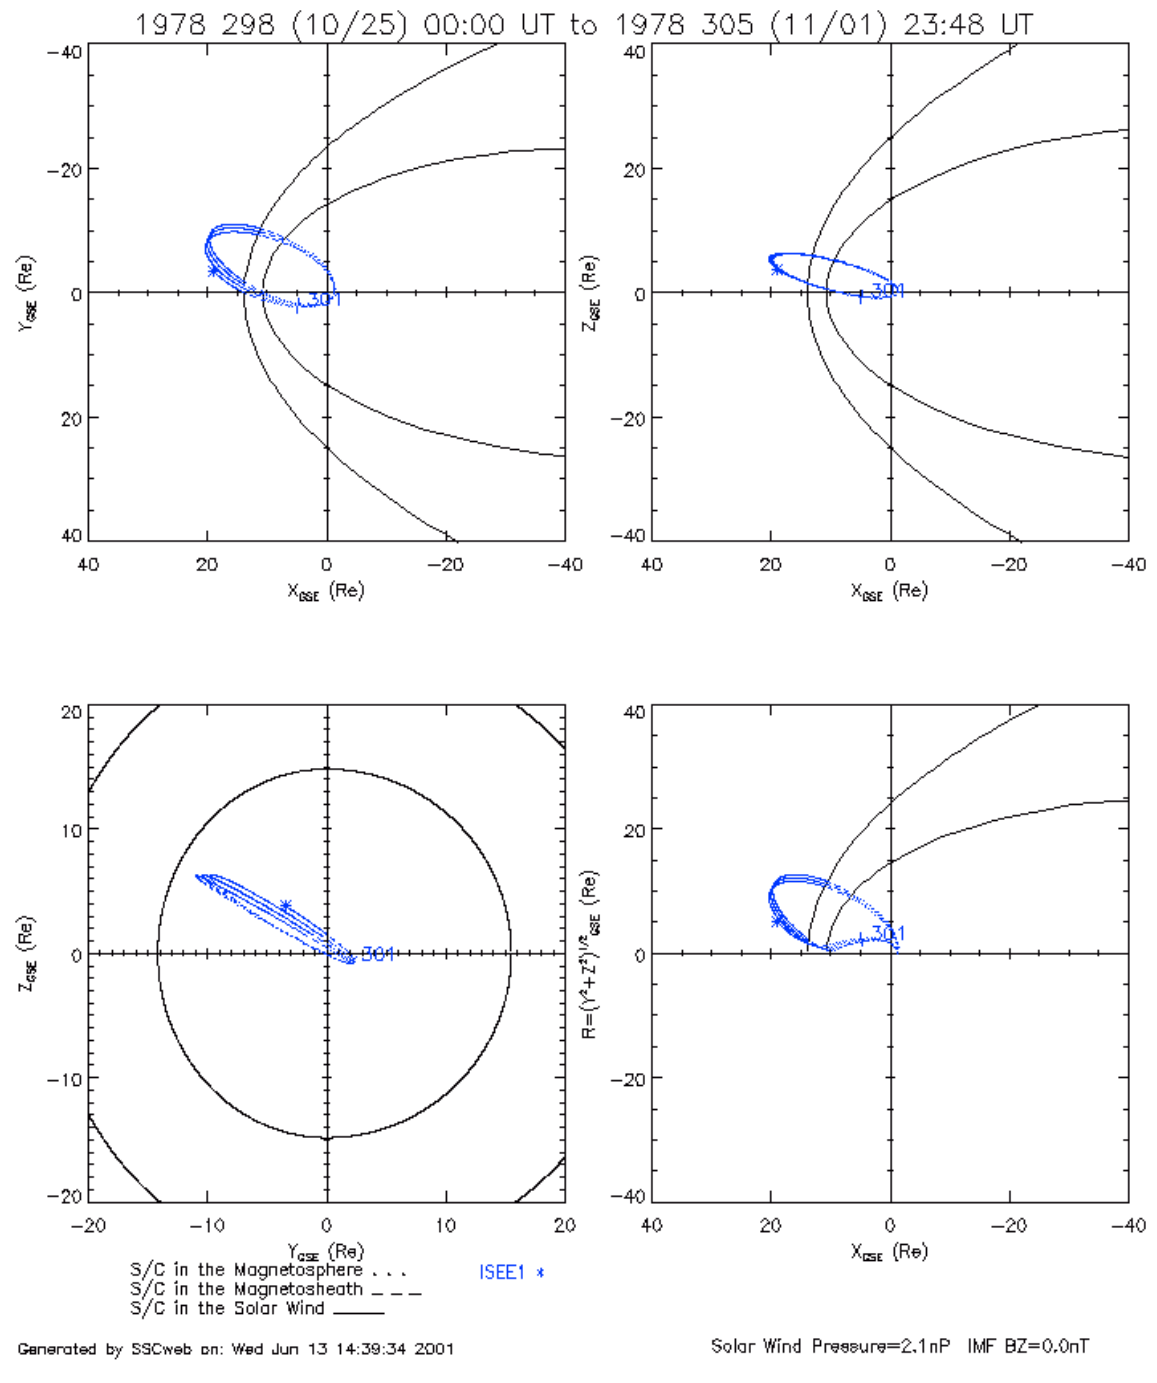
Fig. 3. Orbit of ISEE-1 during the period 25 October 1978 (Day298) to 1 November 1978 (Day305).